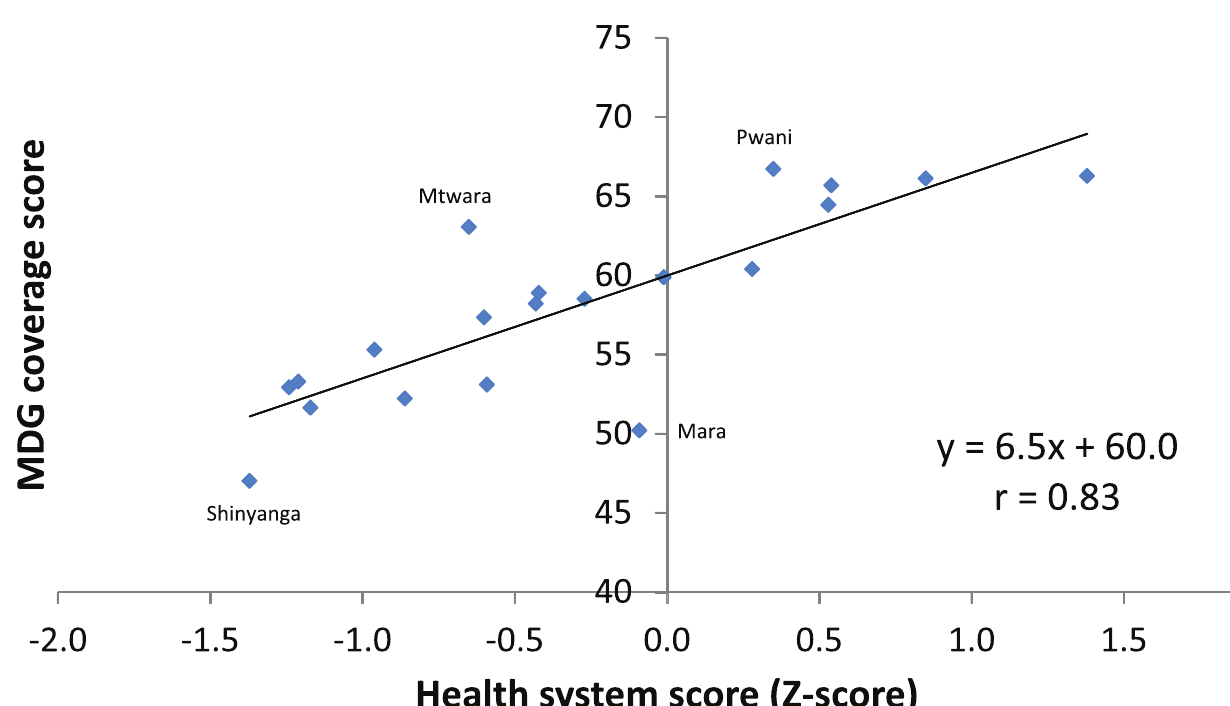
Fig 4. Health MDG coverage score by health system strength score, Tanzania